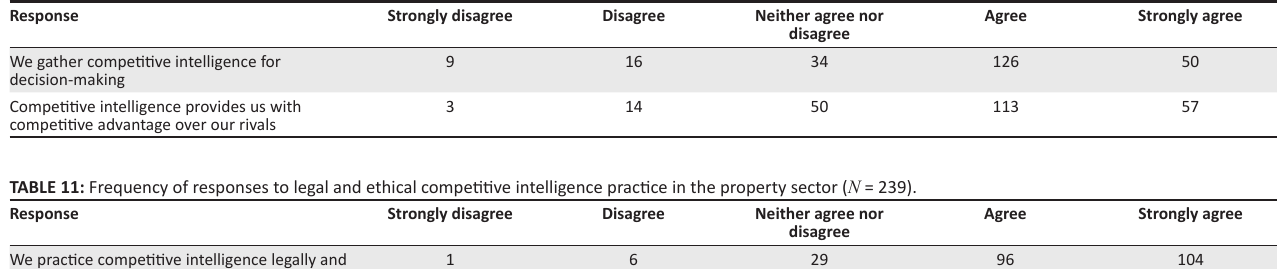
Table 10 indicates the frequency of responses of purpose of CI practice in the property sector.